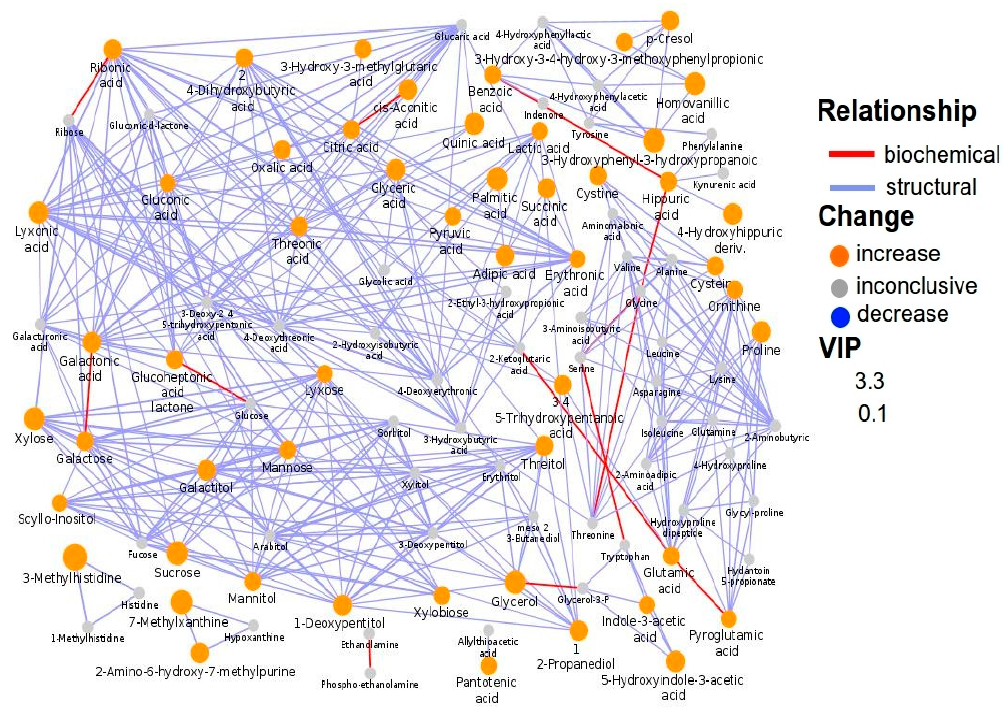
Figure 3. Biochemical network mapping resulting from the comparison between the urine metabolome of ASD children with ADOS-2 CSS ≥ 8 and that of ASD children with ADOS-2 CSS < 8. Metabolites connections are based on biochemical (red edges) and structural (violet edges) similarities. Structural similarity is shown for Tanimoto coefficients ( ≥ 0.7, solid edges) and relaxed scores (dashed edges). Node size displays model VIP and color the direction of change in ASD relative to control samples.